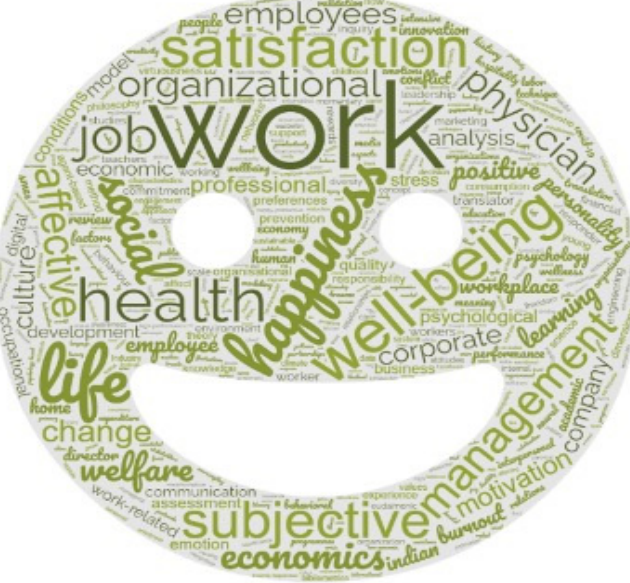
Figure 8. Word cloud of key terms.